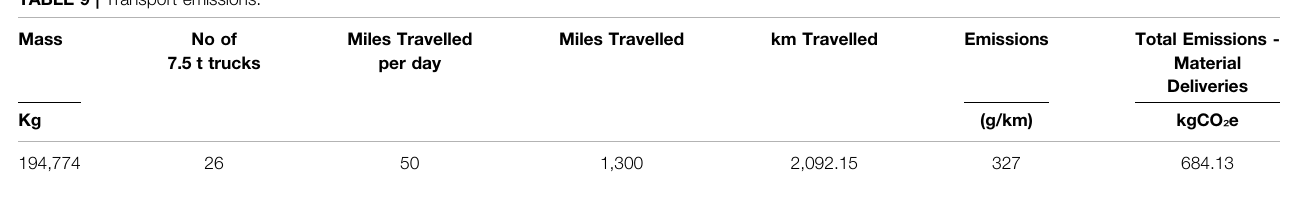
TABLE 9 | Transport